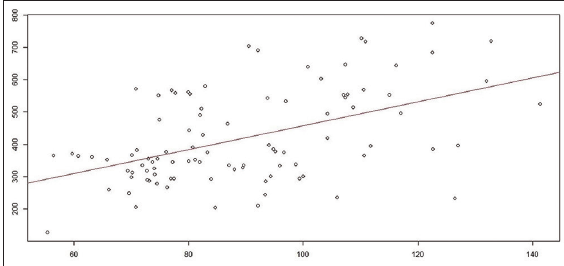
FIGURE 10. Regression line showing the tendency of the linear regression results of the maximum hand grip strength (Y-axis) unit is in Newton and the body weight of more than 50 years (X-axis) unit is in